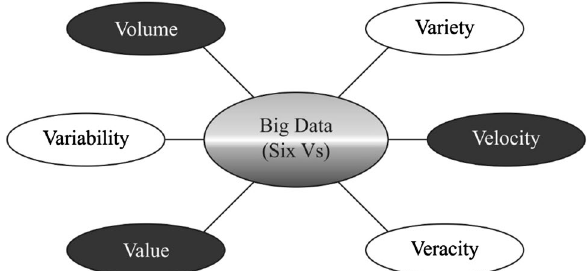
Fig. 1 Six Vs of Big